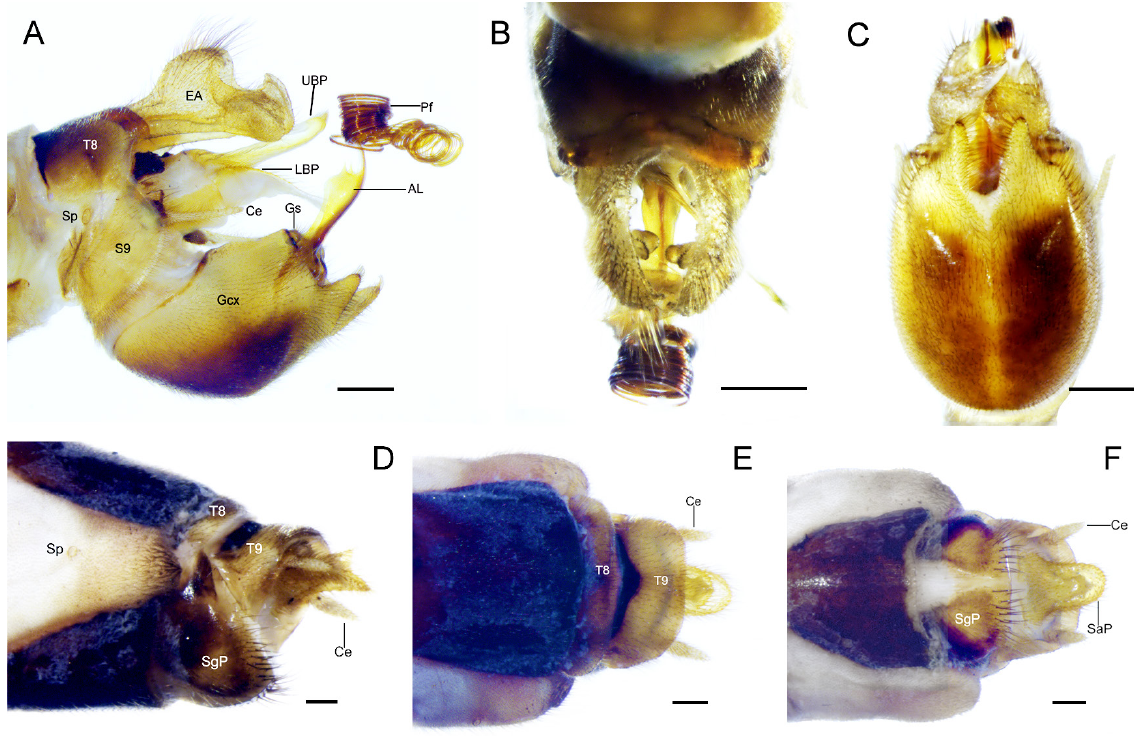
Fig. 4. Bittacus dilobus sp. nov. A–C . ♂, holotype (NWAU). A . Terminalia in lateral view. B . Terminalia in dorsal view. C . Terminalia in ventral view. D–E . ♀, paratype (NWAU). D . Terminalia in lateral view. E . Terminalia in dorsal view. F . Terminalia in ventral view. Abbreviations: see Material and methods. Scale bars: A–C = 0.5 mm; D–F = 0.2 mm.